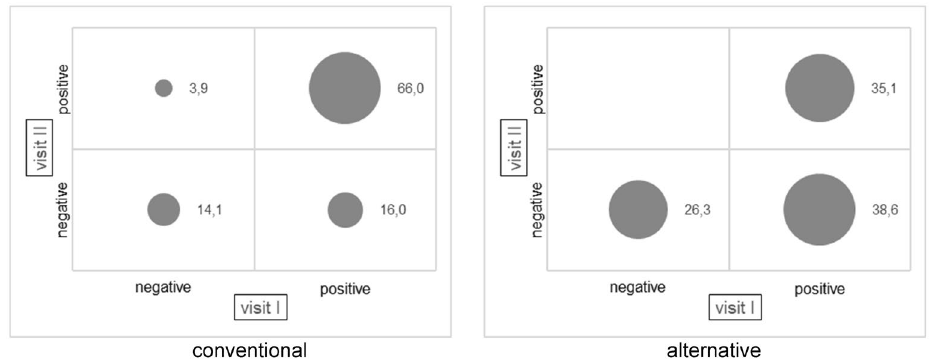
Figure 2. Categories of LA-MRSA-status of animals from beginning of fattening period (visit I) to end of fattening period (visit II) (percentages)—conventional (n = 2*256 = 512) and alternative (n = 2*57 = 114) housing systems.